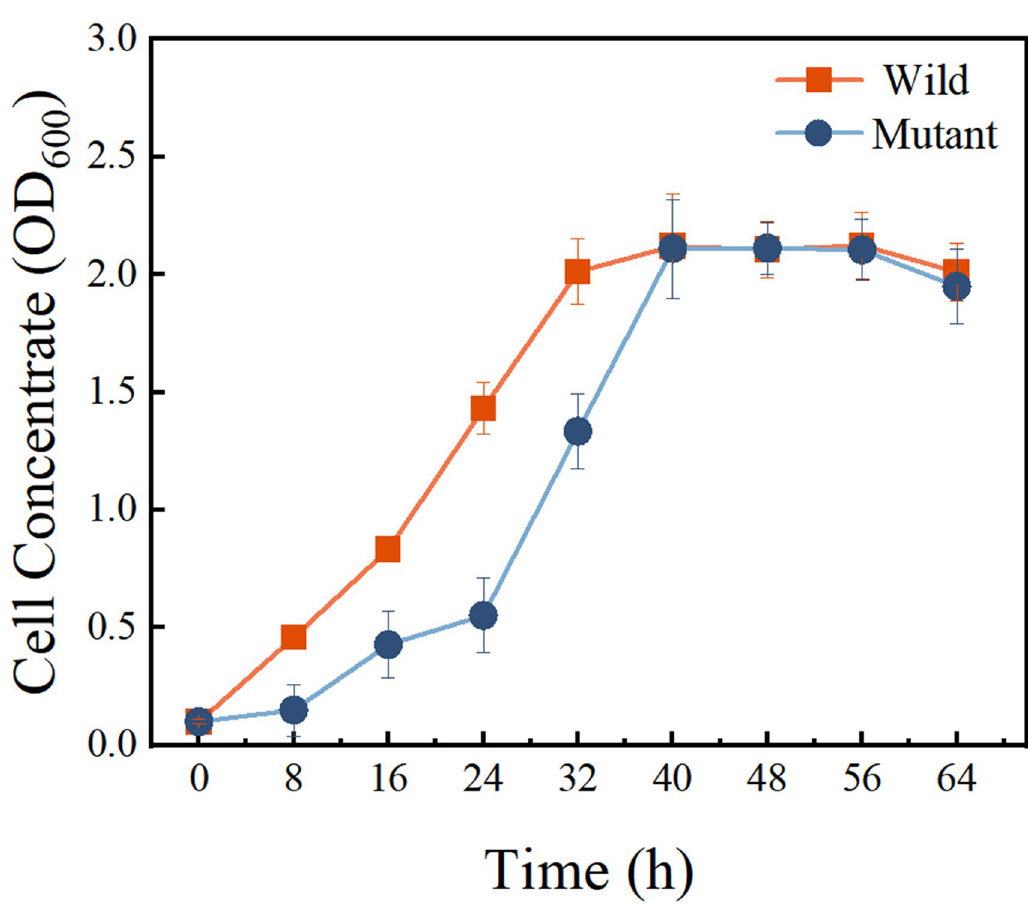
Fig 6. Growth curve of deletion mutant and wild-type